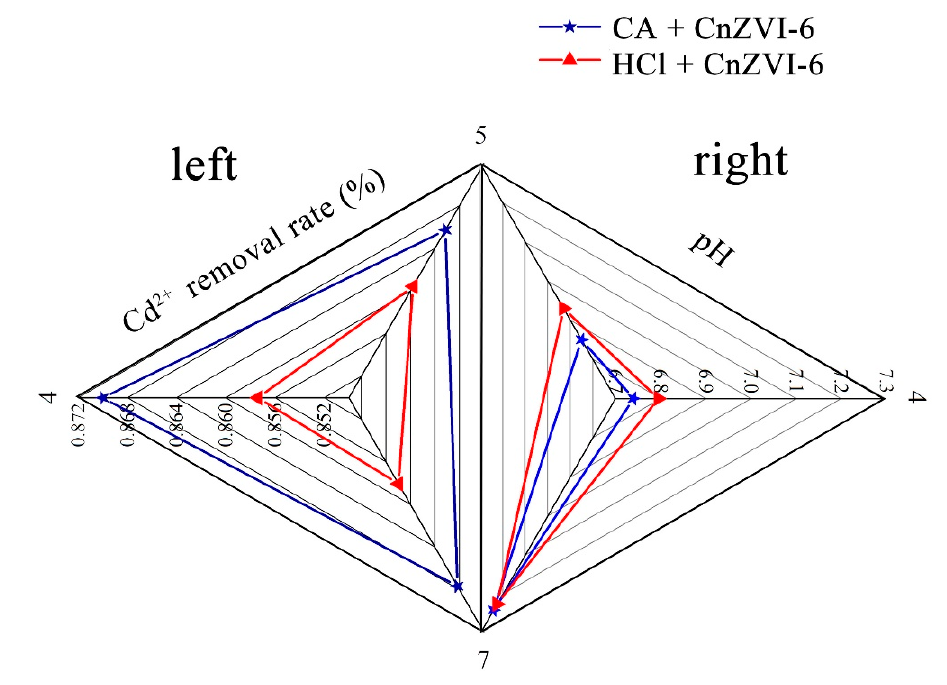
Figure 2. The Cd 2+ removal efficiency with ( ★ ) CA or HCl ( ▲ ) at different pH 4, 5 and 7 ( left ) and the pH change after the reaction ( right ). the pH change after the reaction ( right